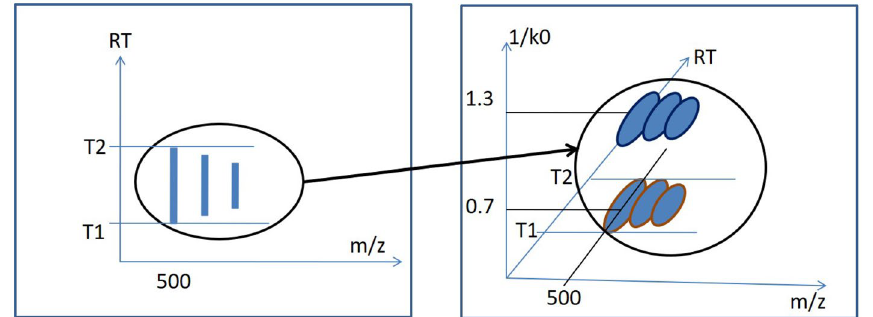
Figure 9. We show the peptide feature in 1 k 0 dimension. In this figure we omit the axis I for simplicity. In the left, we see an usual peptide feature extending along RT and m / z axis. This same feature can get separated into two different features if we consider the additional 1 k 0 dimension, as shown in the